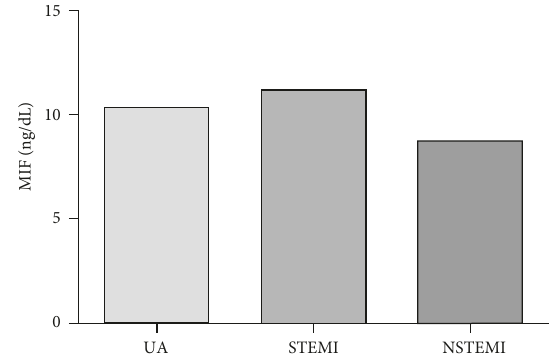
0 . 02) compared (cid:31)